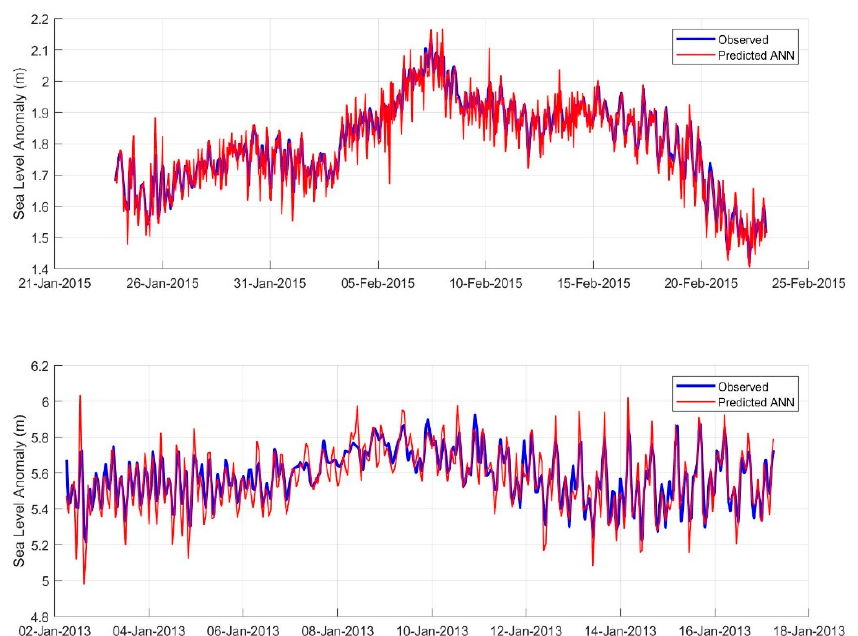
Figure 14. Comparisons between modelled and measured sea level variations during cyclones at selected sites: Upper Panel: Rosslyn Bay gauge, cyclone Marcia, Lower Panel: Broome gauge, cyclone Narelle. Sea levels measured at validation sites are shown in blue, modelled by ANN are shown in red.